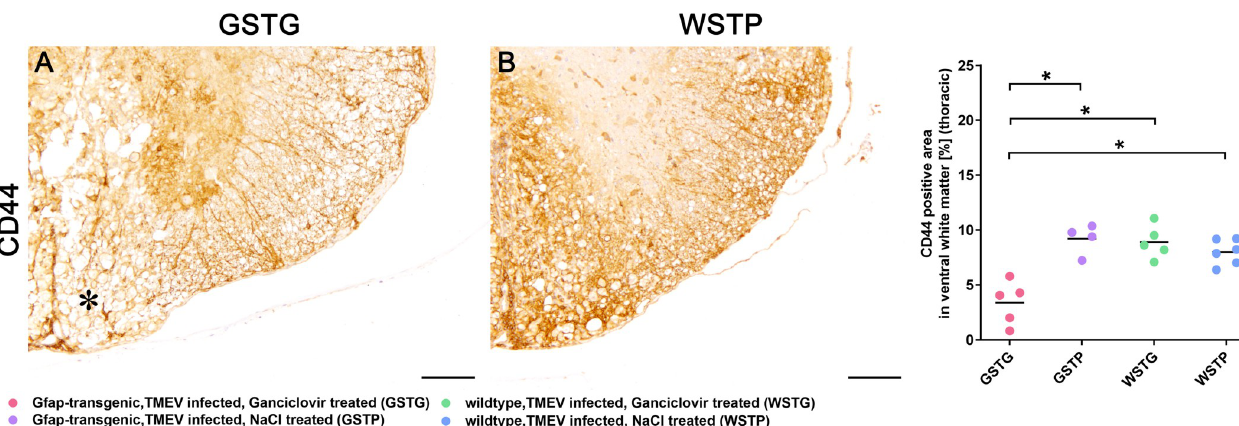
Fig 7. CD44 expression during astrocyte depletion. Immunohistochemistry targeting the cell-surface glycoprotein CD44 was used to evaluate the anchoring of extracellular matrix to astrocytes. Statistical analysis revealed a significant reduction of CD44 positive area in TMEV infected, ganciclovir treated, GFAP- transgenic (GSTG) mice compared to all control groups ( A - C ).A reduction of the CD44 labeled area in the ventral spinal cord white matter of GSTG animals (asterisk, A ) compared to a diffuse and circumferential immunolabelling in control animals ( B , C ) was detected. For each antibody, one cross section of the thoracic spinal cord was evaluated per animal. Data are shown as scatter dot plots. The horizontal bar indicates the mean. Significant differences between GSTG and the control groups obtained by Kruskal-Wallis test followed by Mann–Whitney U post hoc tests are indicated by � , p � 0.05. Bars represent 100 μ m.